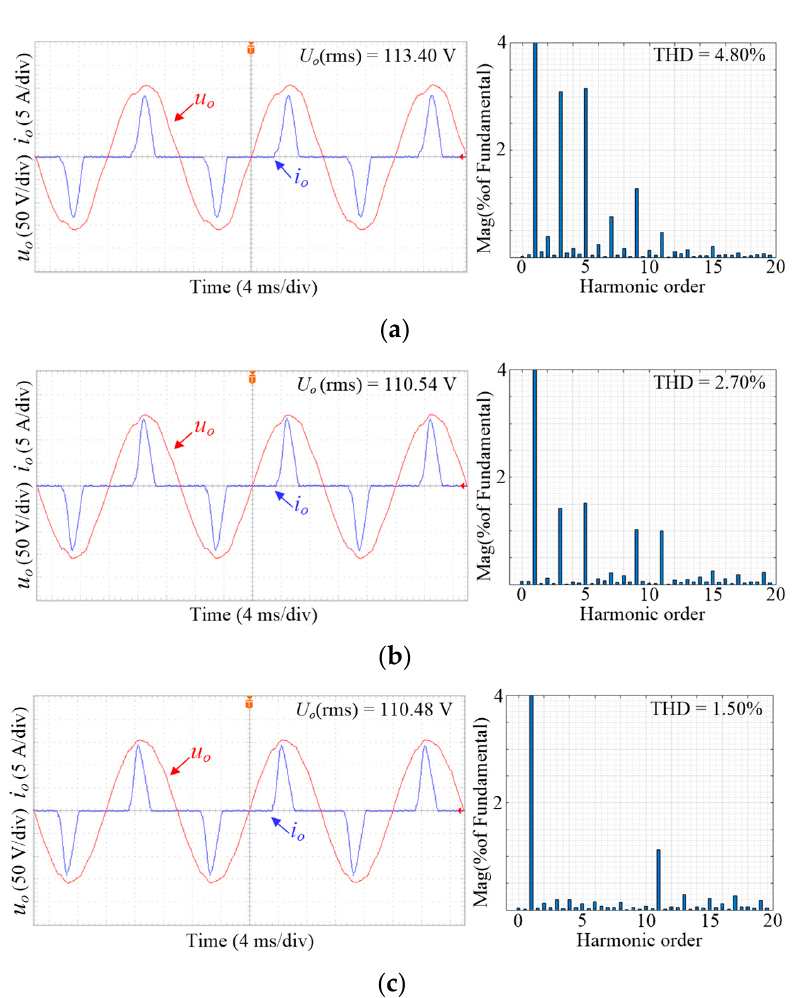
Figure 17. Voltage tracking error of different control strategies under nonlinear load with ( a ) LADRC; ( b ) SRFPI-LADRC; and ( c ) HC-SRFPI-LADRC.